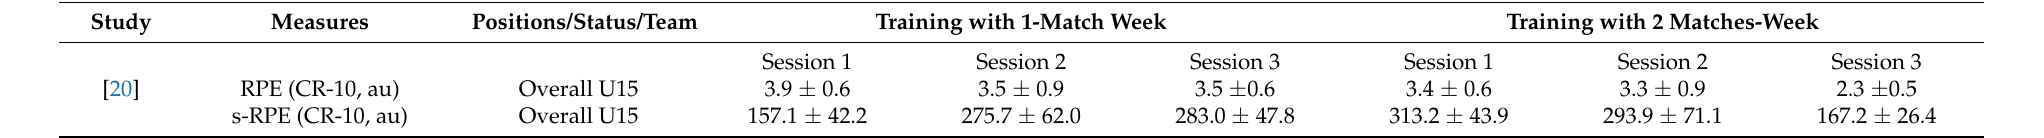
Table 6. Results for internal training intensity in one or two matches per week, by match-day minus and by player